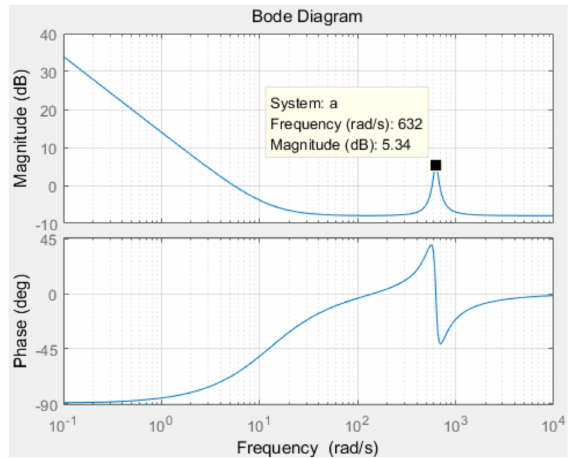
Figure 12. Bode plot of PI + R controller.